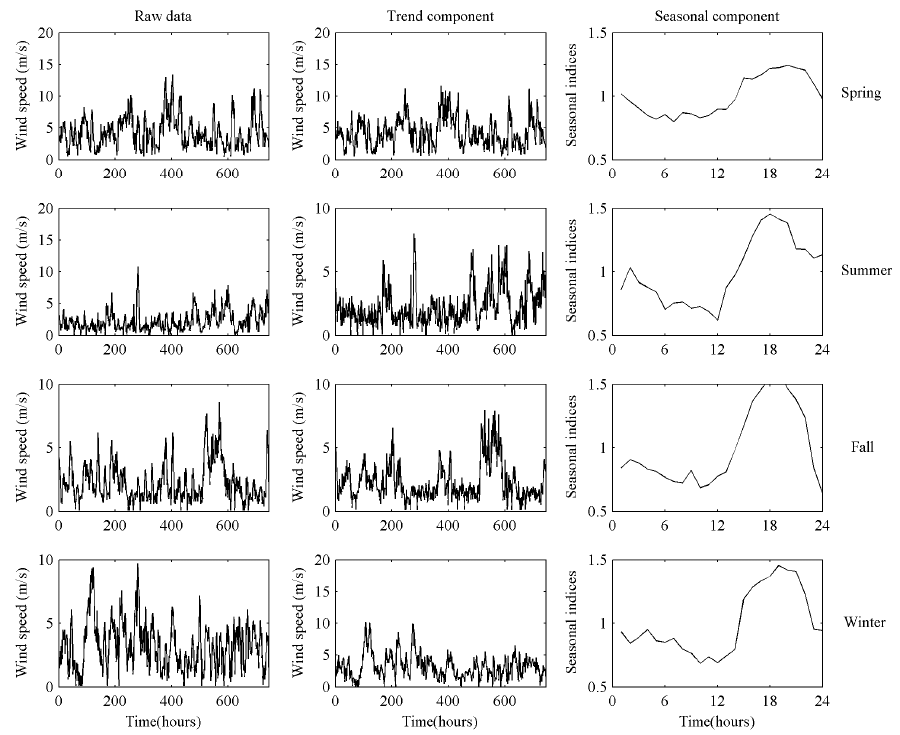
Figure 4. De-seasonalization process of original wind speed data using SSA in four cases. Figure 4. De ‐ seasonalization process of original wind speed data using SSA in four cases. Table 2. Seasonal indices of the original wind speed data in the four Table 2. Seasonal indices of the original wind speed data in the four cases.